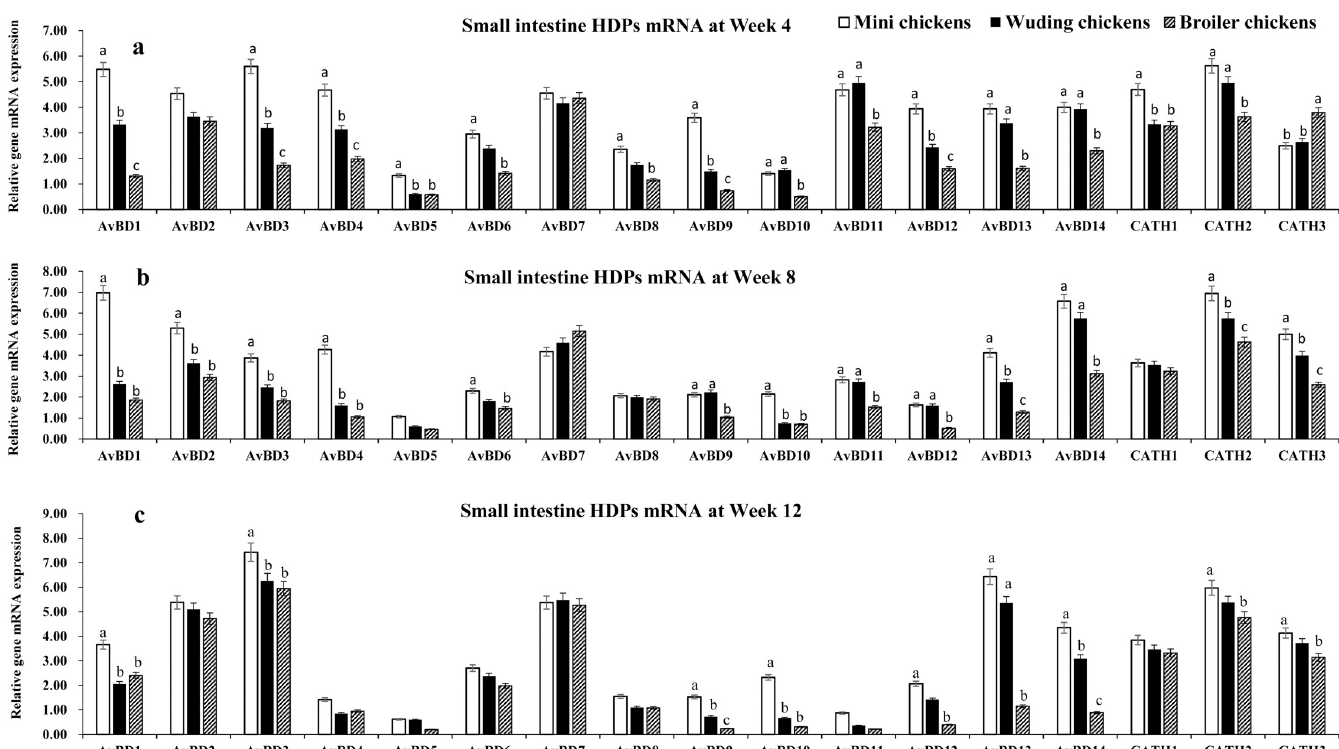
Fig 2. HDP mRNA expression in the small intestine. mRNA expression of AvBD 1–14 and CATH 1–3 genes in the small intestine of three chickens at weeks 4 (a), 8 (b), and 12 (c). Twenty chickens per type per time point were used and gene expression was investigated with RT-qPCR. The experiment was repeated three times. Data are expressed as the mean ± SEM at each age for each chickens and different letters on top of each bar represent significant differences (p < 0.05) among chickens.